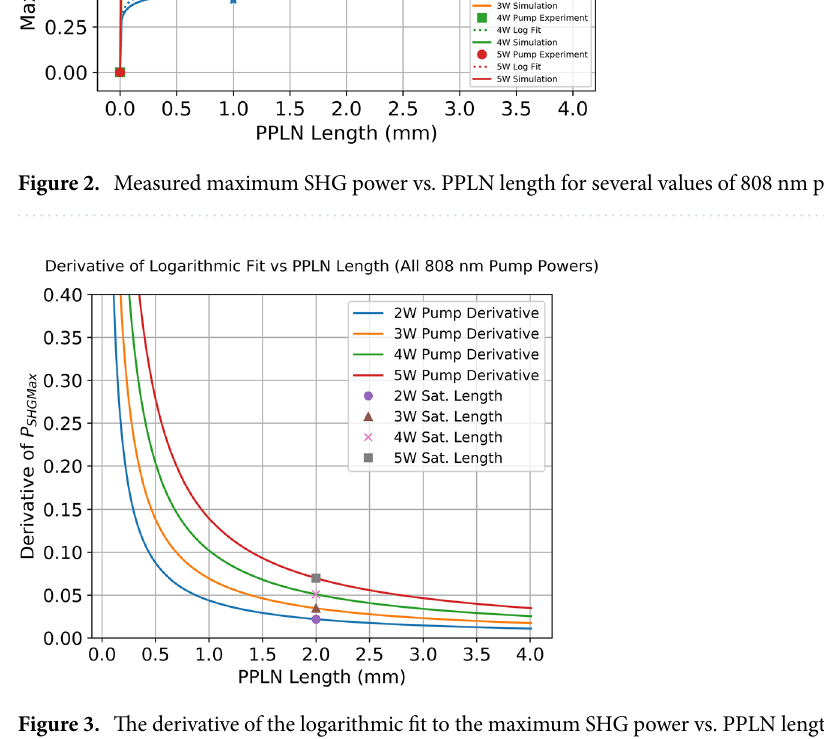
Figure 3. The derivative of the logarithmic fit to the maximum SHG power vs. PPLN length for several values of 808 nm pump power. The markers denote the saturation length to be 2 mm for all pump